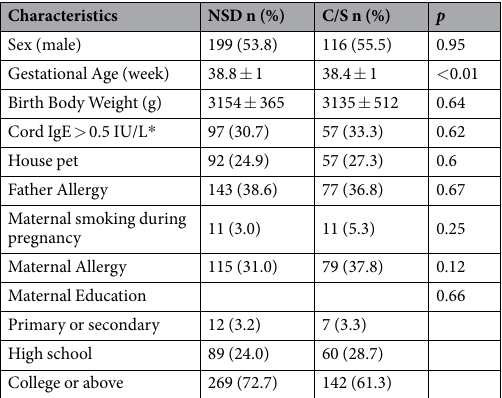
Table 1. Demographic characteristic. Total number of NSD: 370. Total number of C/S: 209. * Cord IgE: based on 487 samples (NSD: 316; C/S: